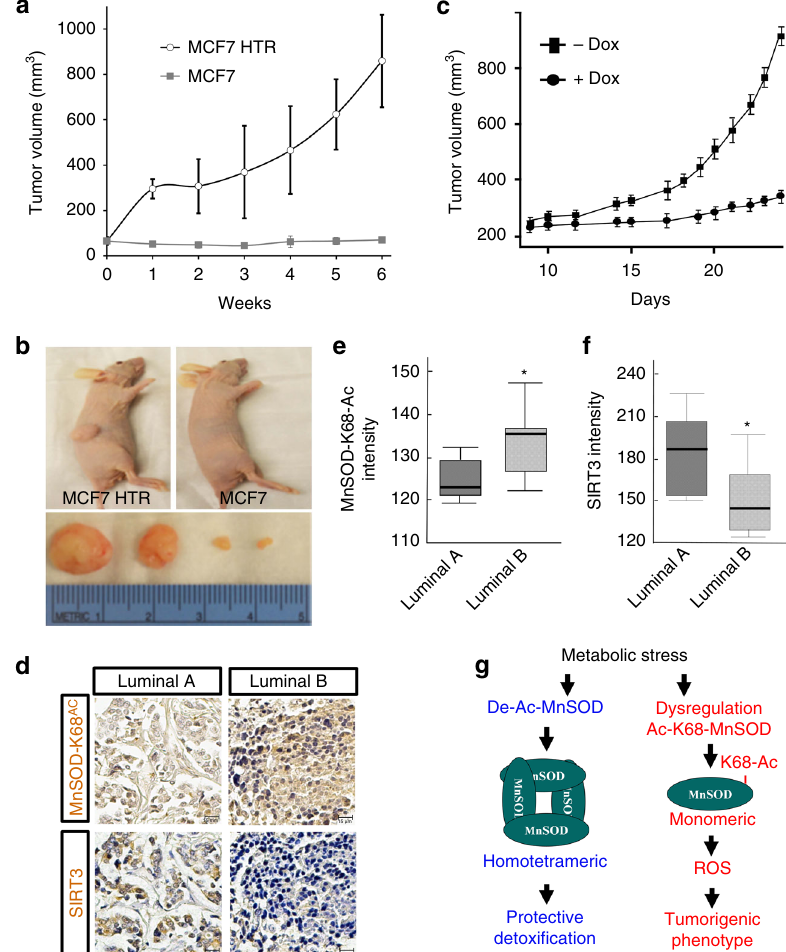
Fig. 8 Luminal B human breast tumors exhibit a SIRT3/MnSOD-K68-Ac signature. a , b MCF7 and MCF7-HTR cells (5.0 × 10 6 ) were implanted into both hind limbs of nude mice and tumor volumes were measured for 6 weeks. a Error bars represent ± 1 SEM. b Representative images of the tumors from MCF7-HTR (left panel) and MCF7 cells (right panel) at 6 weeks. c MCF7-HTR doxycycline-inducible MnSOD K68R cells were implanted into hind limbs of nude mice and tumor volumes were monitored for 4 weeks. Error bars represent ± 1 SEM. d Luminal breast cancer sample TMA stained with anti-MnSOD- K68-Ac or anti-SIRT3 antibodies. e , f Quanti fi ed TMA consisting of luminal A ( n = 37) and luminal B ( n = 38) samples immunostained for e MnSOD-K68- Ac; and f SIRT3. The shaded boxes represent the interquartile range; whiskers represent the 10th – 90th percentile range. Experiments were done in triplicate. * p < 0.05. A t -test was used to compare data between the two groups. g Schematic of the dichotomous role for MnSOD in normal cells (i.e., protection, blue) versus tumor promoter and/or and Tam resistance